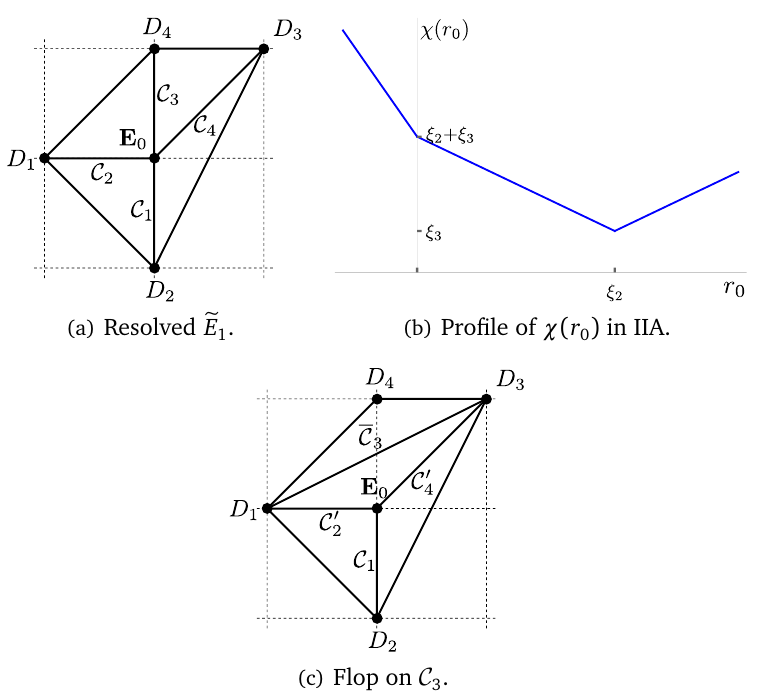
Figure 8: The resolved (cid:101) E